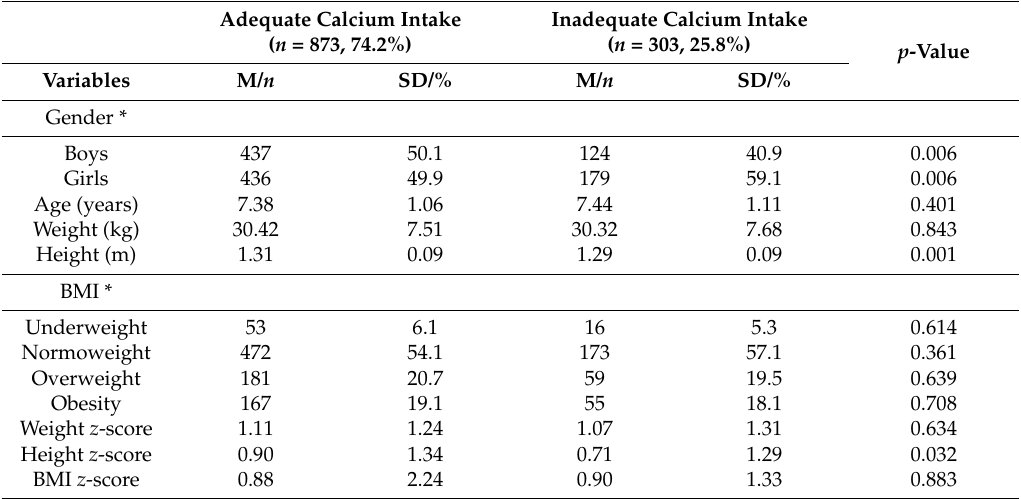
Table 1. Schoolchildren’s anthropometric characteristics according to calcium